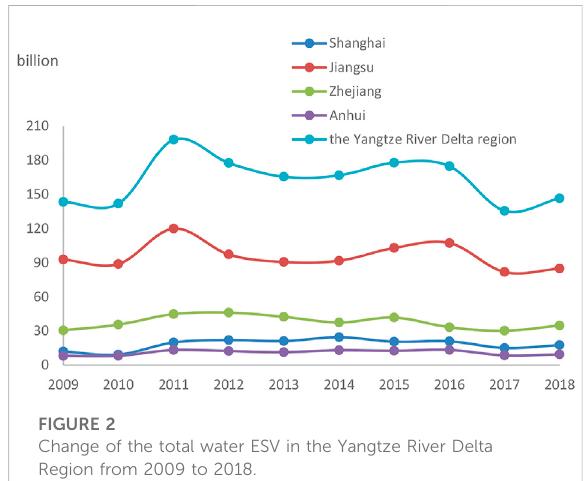
FIGURE 2 Change of the total water ESV in the Yangtze River Delta Region from 2009 to